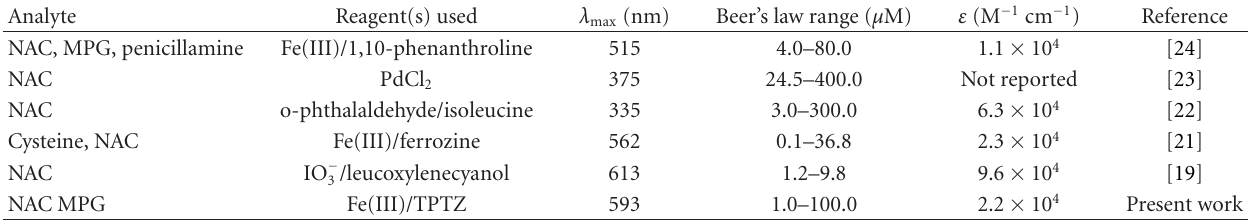
Table 4: Comparison of the equilibrium spectrophotometric methods for NAC and MPG determination.